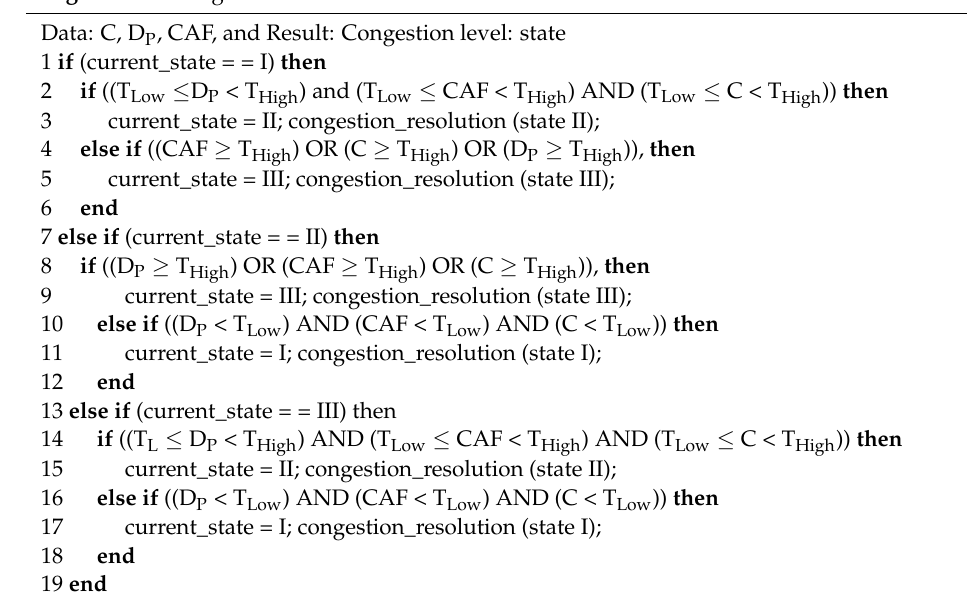
Algorithm 1 Congestion detection